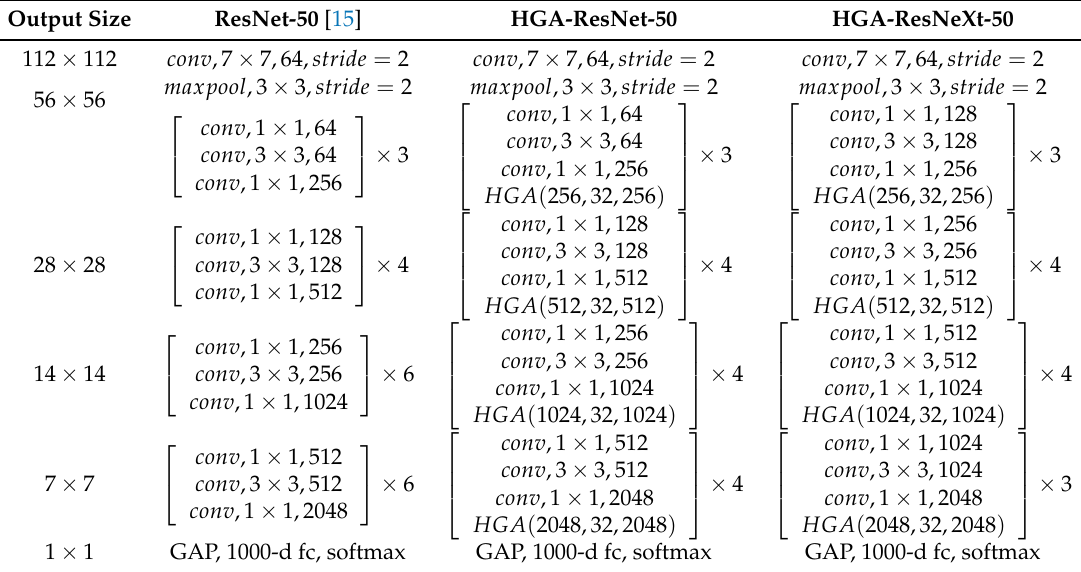
Table 1. The embedding methods of HGA for different modern